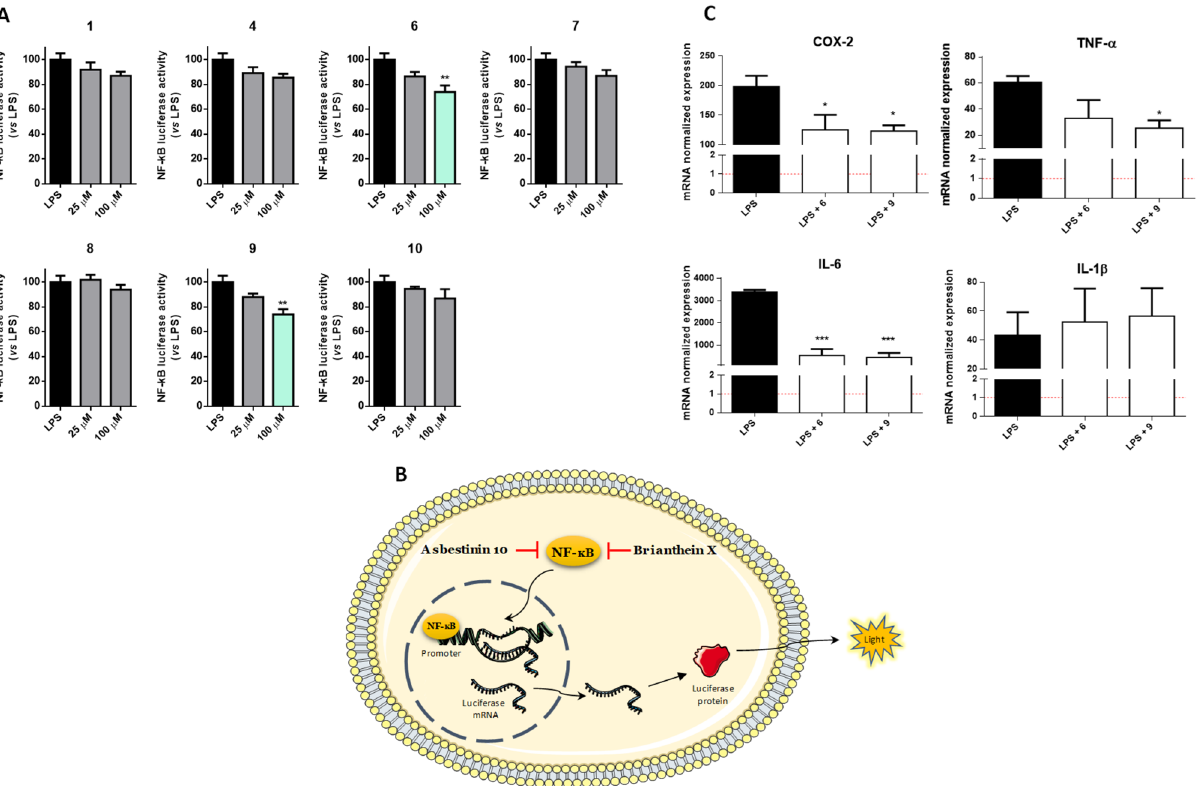
Figure 7. ( A ) NF-κB activation in LPS-challenged THP-1 Lucia cells in the presence of compounds 1 , 4 , 6–10 for 24 h. Incubation with LPS corresponds to maximum NF-κB response, with molecules capable of inhibiting the activation of the transcription factor ( 6 and 9 ) presenting lower activity values. ( B ) Experimental model used for the assessment of NF-κB in THP-1 luciferase-transfected cells. ( C ) COX-2, IL-6, TNF-α and IL-1β mRNA expression in THP-1 cells. mRNA expression was determined by qPCR after normalization with GAPDH reference gene. Horizontal dashed red line corresponds to the basal expression of the gene in untreated cells. * p < 0.05; ** p < 0.01; *** p <